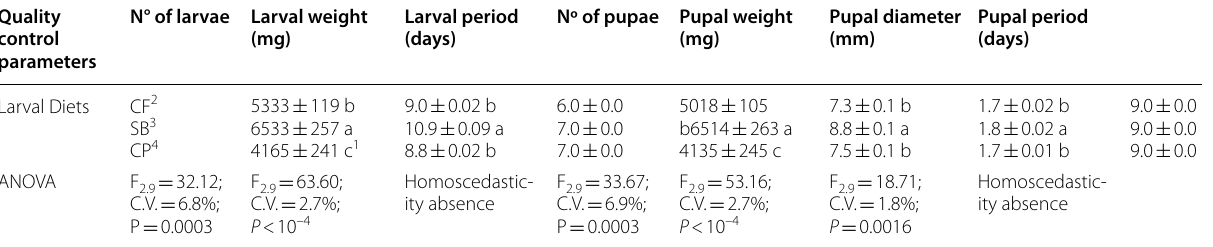
Table 3 Mean ( SE) quality control parameters for Ceratitis capitata reared on the three larval diets ±